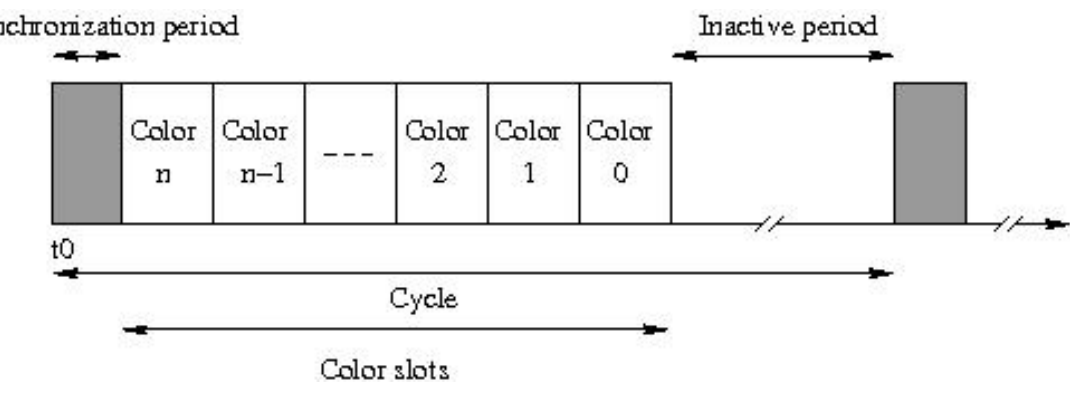
Figure 4. Cycle with the active period and the inactive